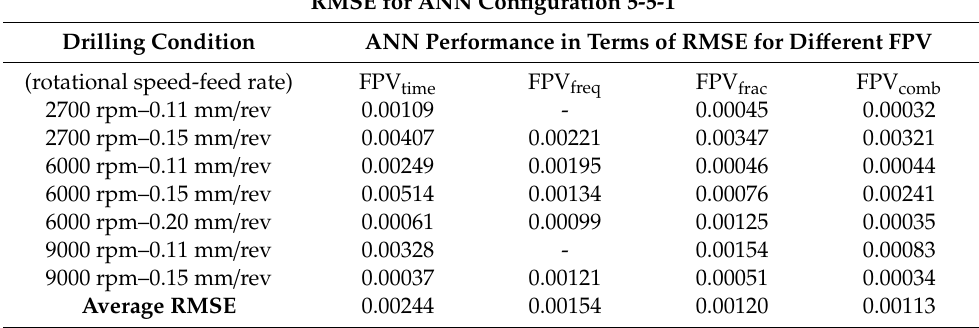
Table 2. Performance of the 5-5-1 artificial neural network (ANN) configuration expressed as root mean square error (RMSE) in tool wear curve reconstruction for each drilling condition and each constructed feature pattern vector